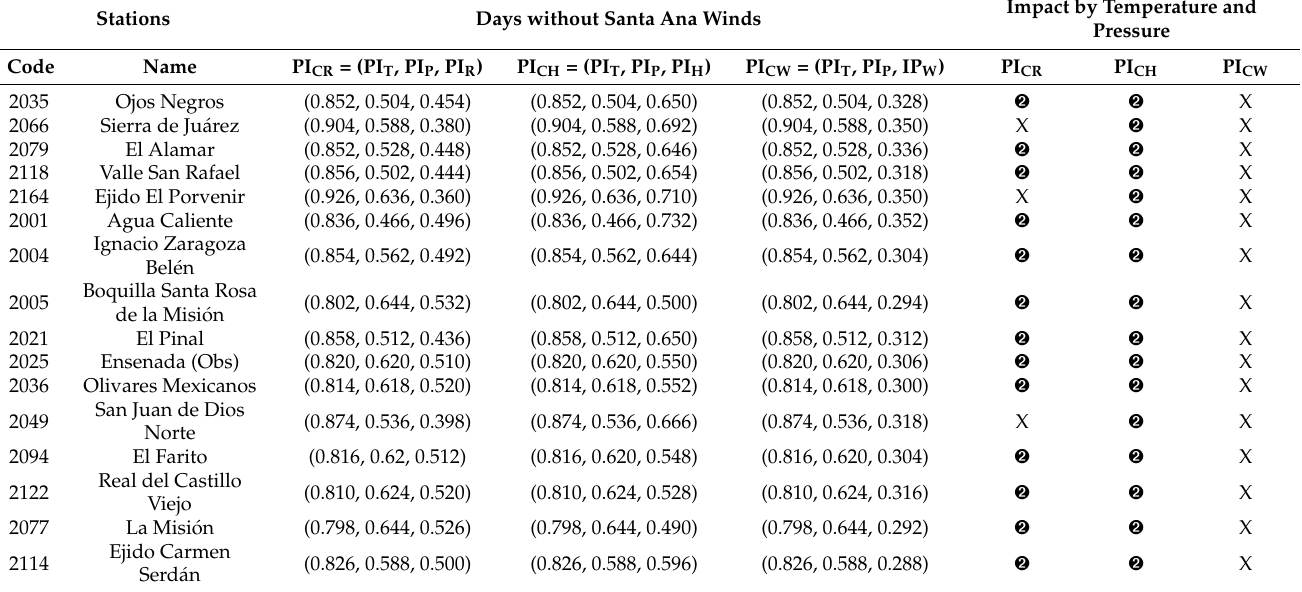
Table 6. Climate predictability index for days without Santa Ana winds and correlation between meteorological